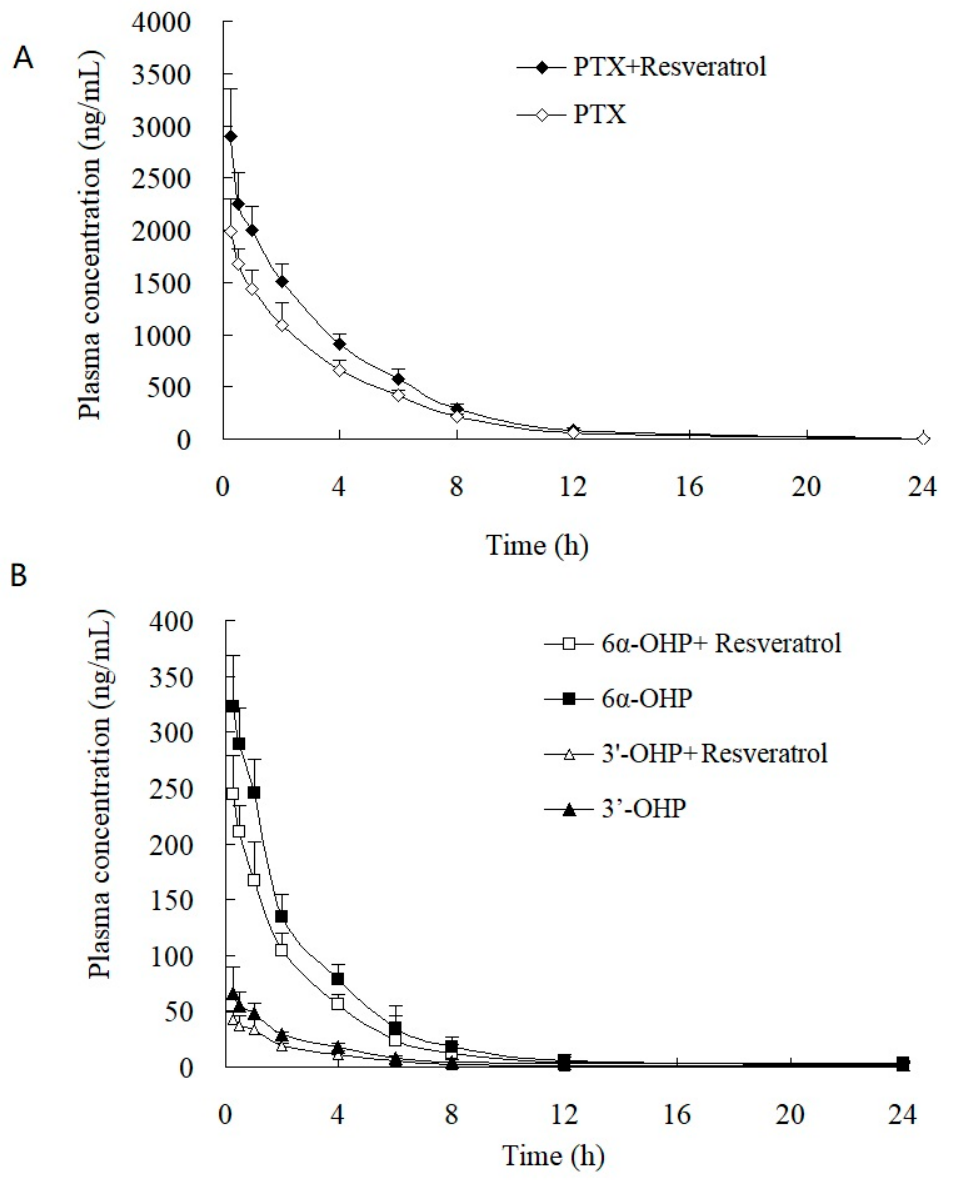
Figure 4. Plasma concentration–time profiles of PTX, 6 α -OHP, and 3 ′ -OHP in post xenograft nude mice intravenously administered with PTX solution at 5 mg/kg. ◆ , , and △ : the concentration of PTX, 6 α -OHP, and 3 ′ -OHP in plasma in the presence of resveratrol, respectively; ◇ , ■ , and ▲ : the concentration of PTX, 6 α -OHP, and 3 ′ -OHP in plasma in the absence of resveratrol, respectively.